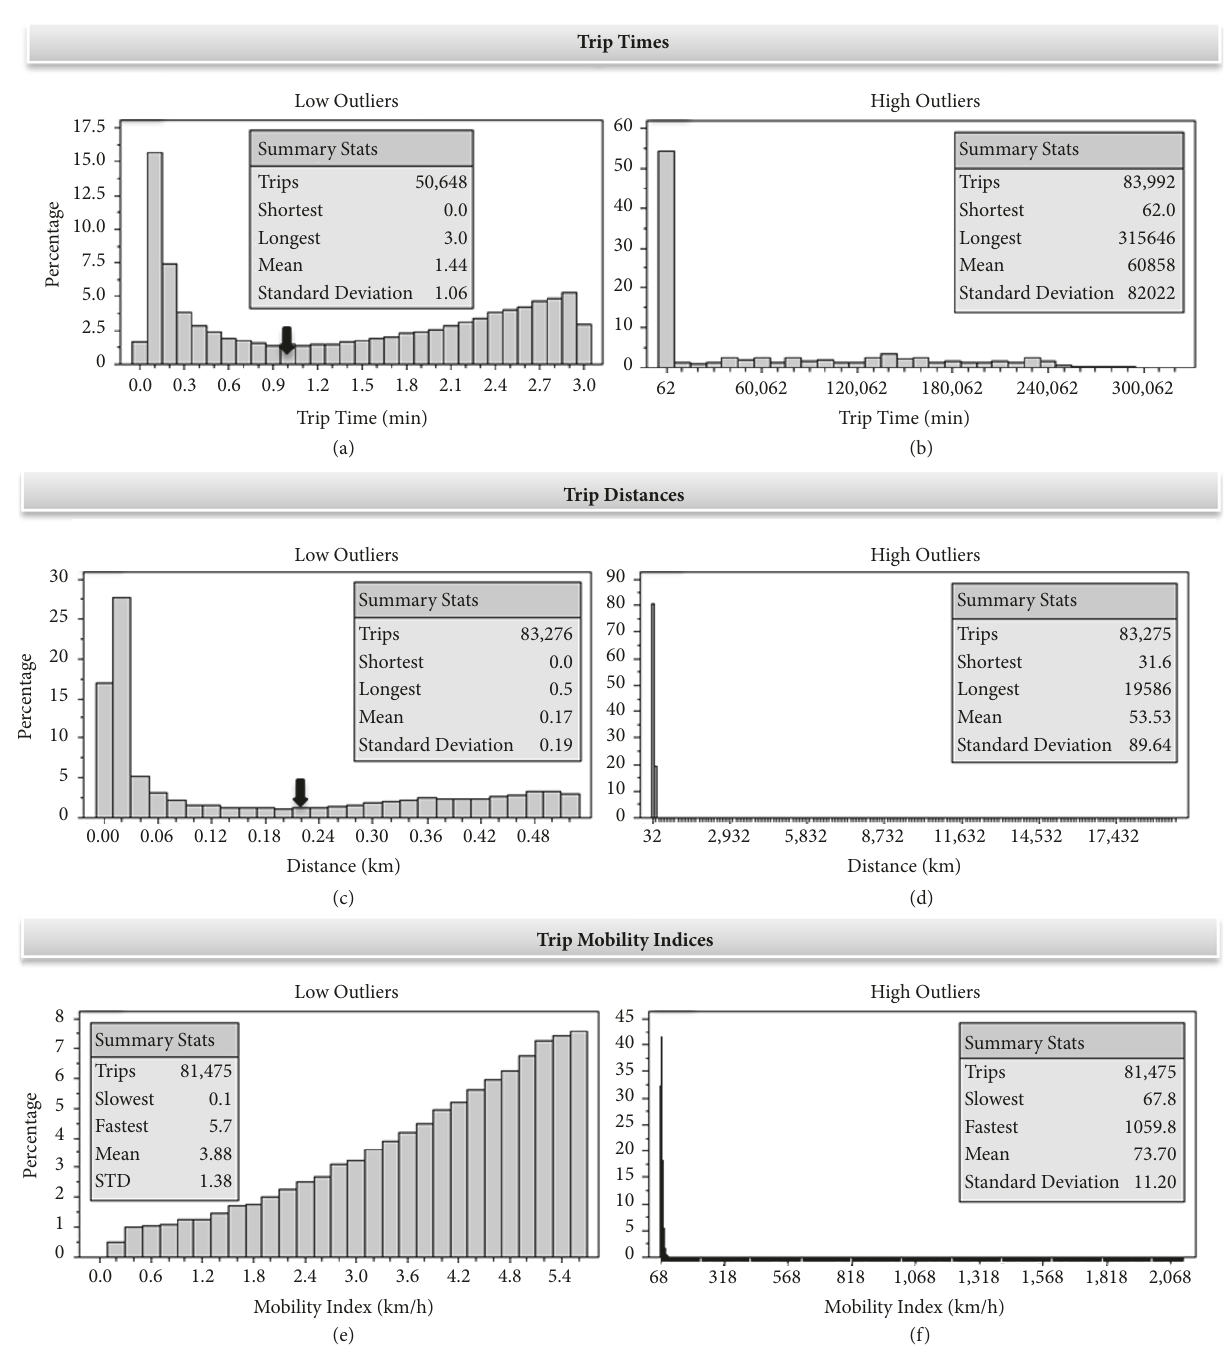
Figure 1: Distribution of outlier trip times, distances, and mobility